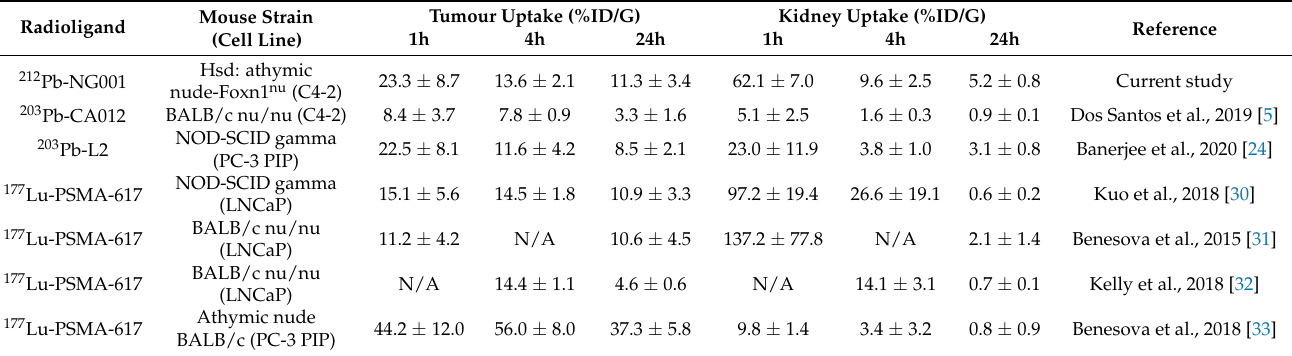
Table 3. Tumour and kidney uptake of various radiolabelled PSMA-binding ligands after 1, 4 and 24 h. N/A, not available. Radioligand Mouse Strain (Cell